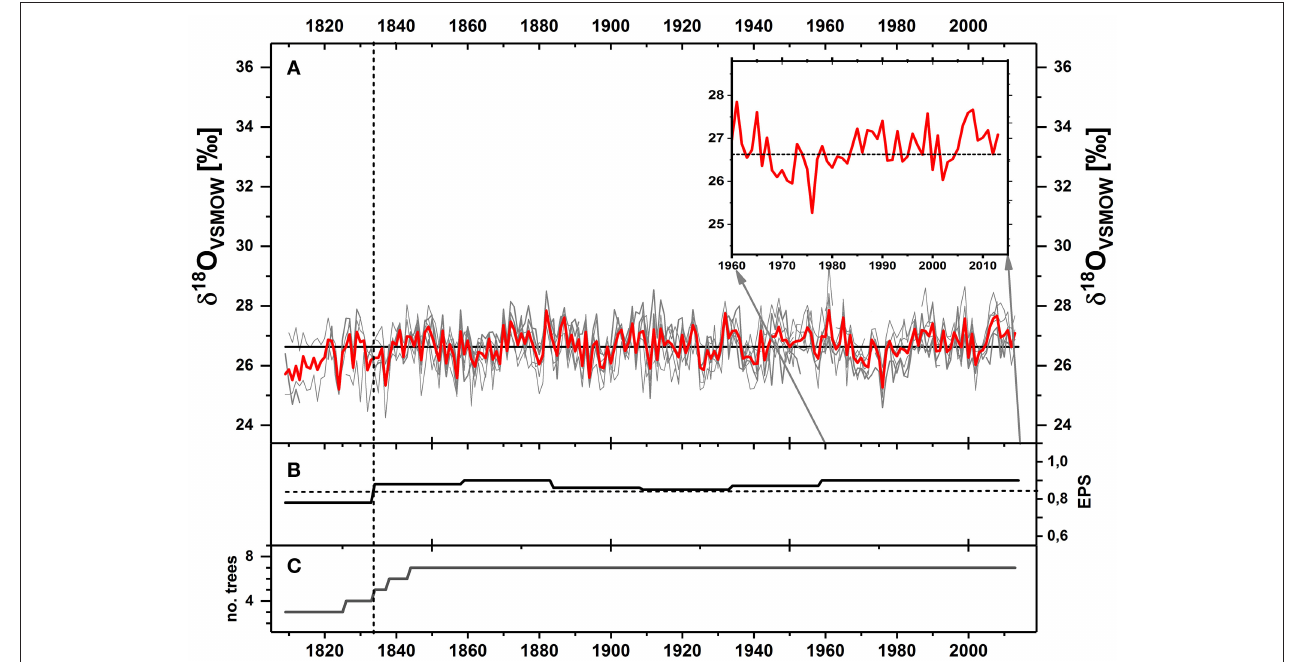
FIGURE 3 | (A) 204 year δ 18 O Tree − ring chronology (1809–2013) of Nothofagus pumilio trees from the Perito Moreno Glacier. Gray curves reflect the seven individual δ 18 O TRC time-series, bold red line the respective annual δ 18 O TRC mean of all trees. Bold horizontal black line: long-term mean of averaged time series. Vertical dotted line indicates the year, when threshold of EPS > 0.85 is reached (1833). Inlay shows δ 18 O TRC chronology (red curve) and long-term mean (horizontal line) for the period 1960–2013. (B) Expressed Population signal (EPS) calculated for a 50 year window with an 25 year overlap. Dotted horizontal line indicates 0.85 threshold. (C) Sample depth indicating the number of trees during the respective